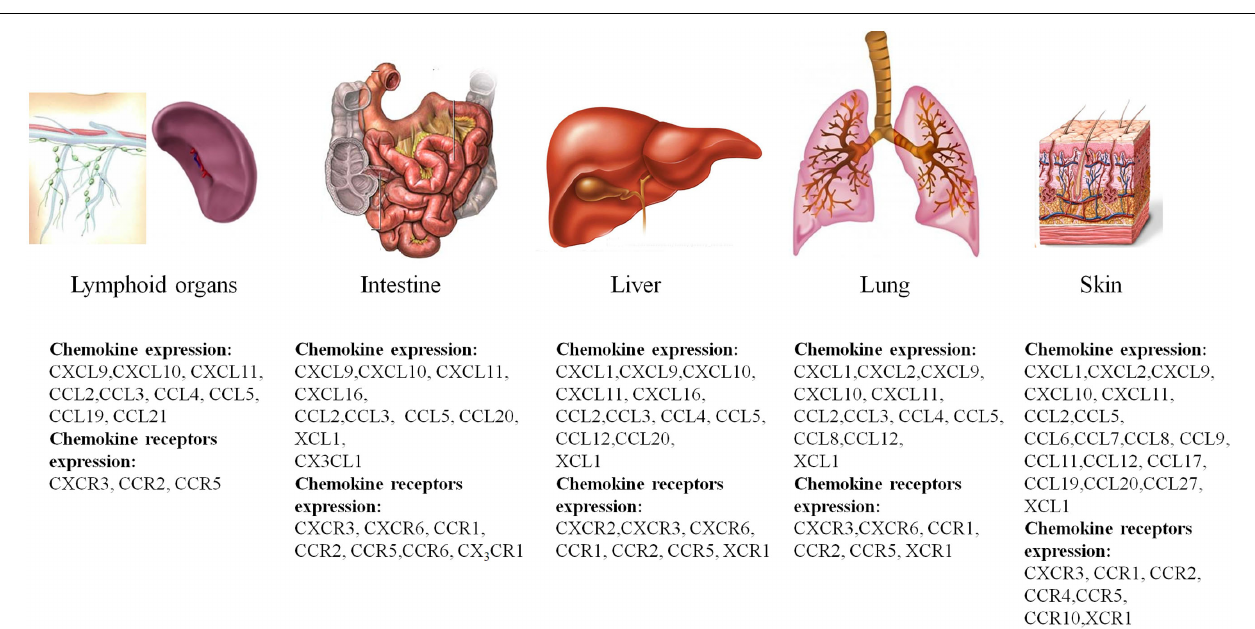
FIGURE 1 | Overview of chemokine and chemokine receptor expression in the major organs targeted by GVHD. Shown are the major target organs that are affected by GVHD, the intestine, liver, lung, and skin, and the major chemokines and chemokine receptors that are expressed during the course of the